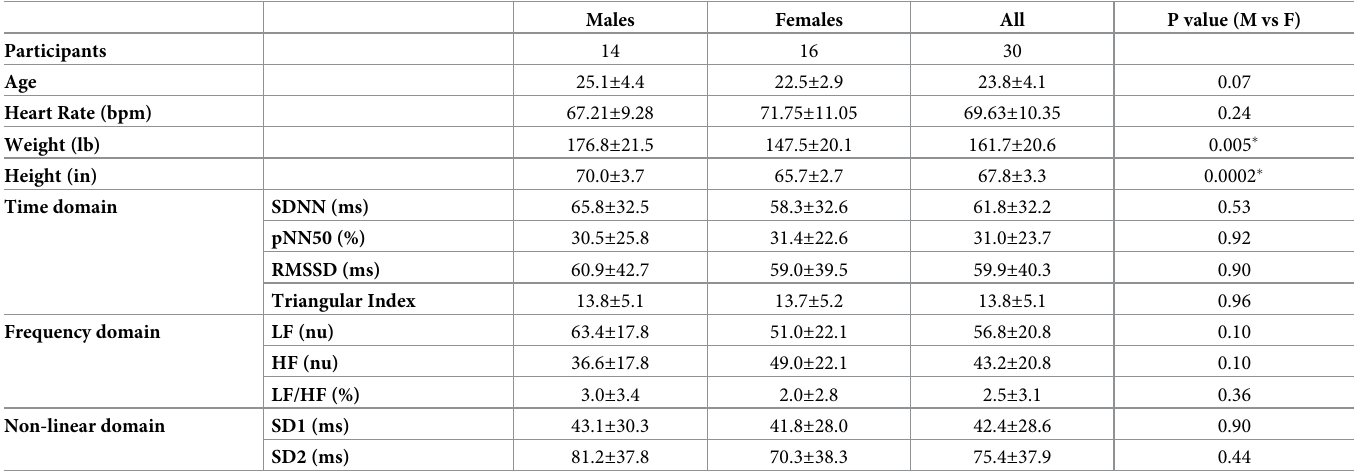
Table 1. Demographics and baseline parameters for the